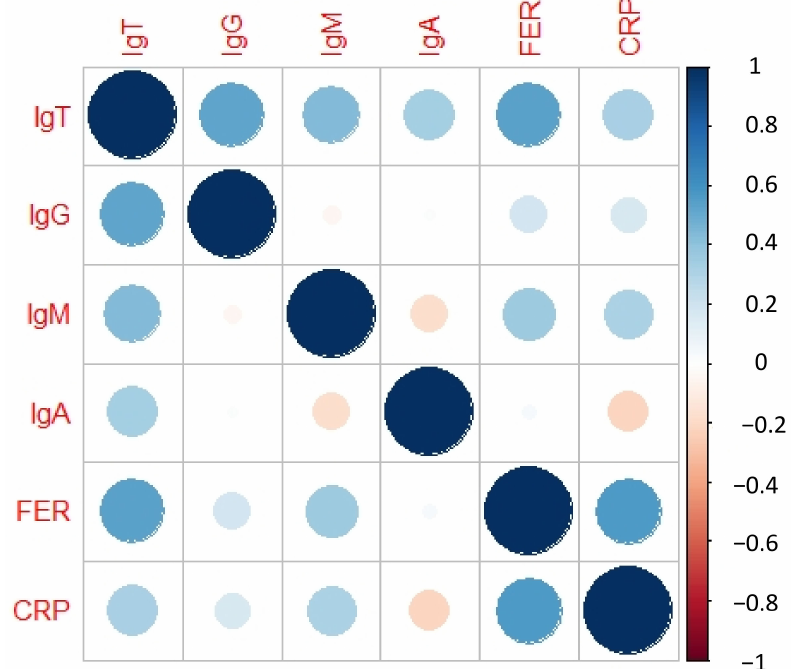
Figure 8. Correlation matrix. The size of the circles shows the correlation level highlighted on the left bar of the figure. Abbreviations: total specific Immunoglobulins (sIgT), specific Immunoglobulins G (sIgG), specific Immunoglobulins M (sIgM), specific Immunoglobulins A (sIgA), together with Ferritin (FER) and C Reactive Protein